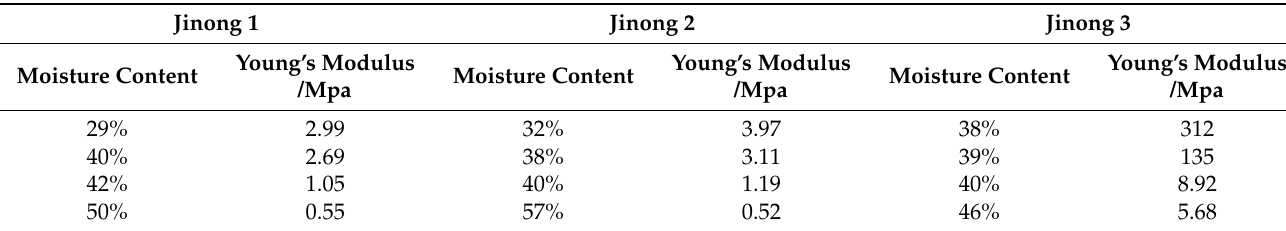
Table 2. The changes in tri ‐ axial dimensions for the three varieties of the Cyperus esculentus seed before and after hydroponics.